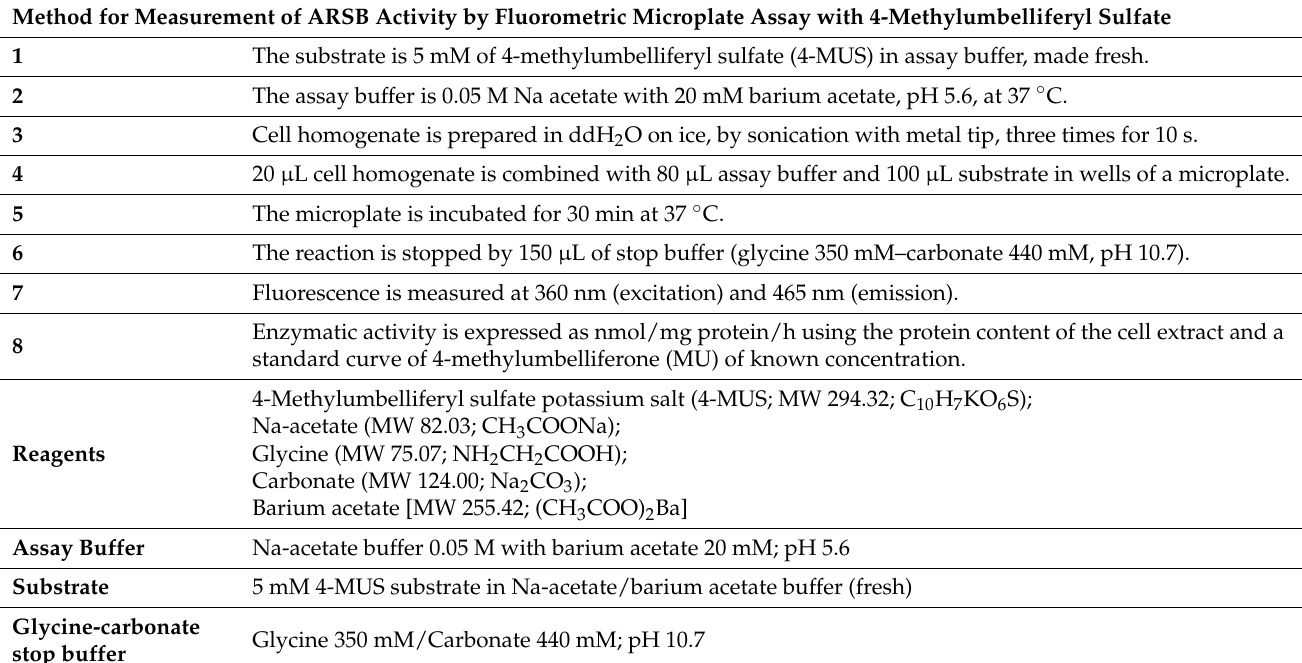
Table 1. The fluorometric plate assay for ARSB uses cell homogenate, not cell lysate. Units are expressed as nmol/mg protein/h